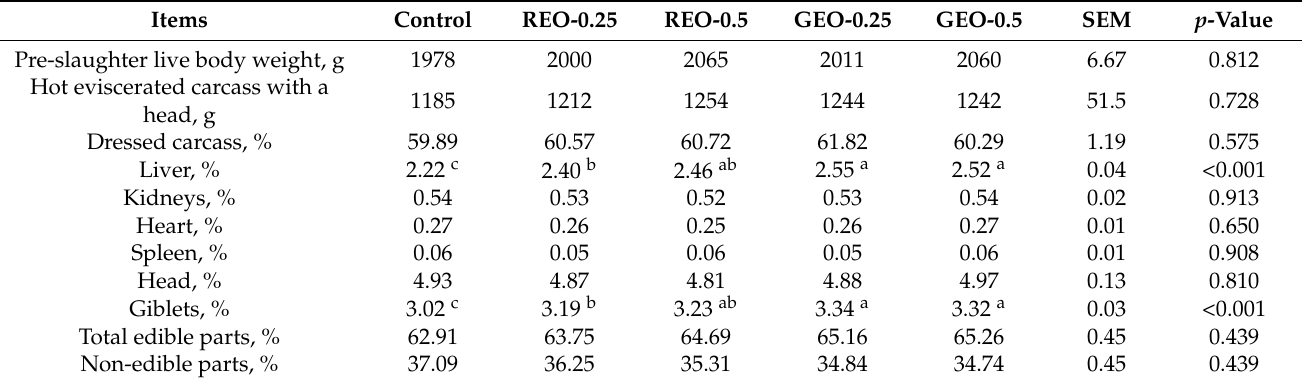
Table 4. Effect of the dietary supplementation of rosemary and ginger essential oils on carcass traits of growing NZW rabbits at the end of the experiment ( n =